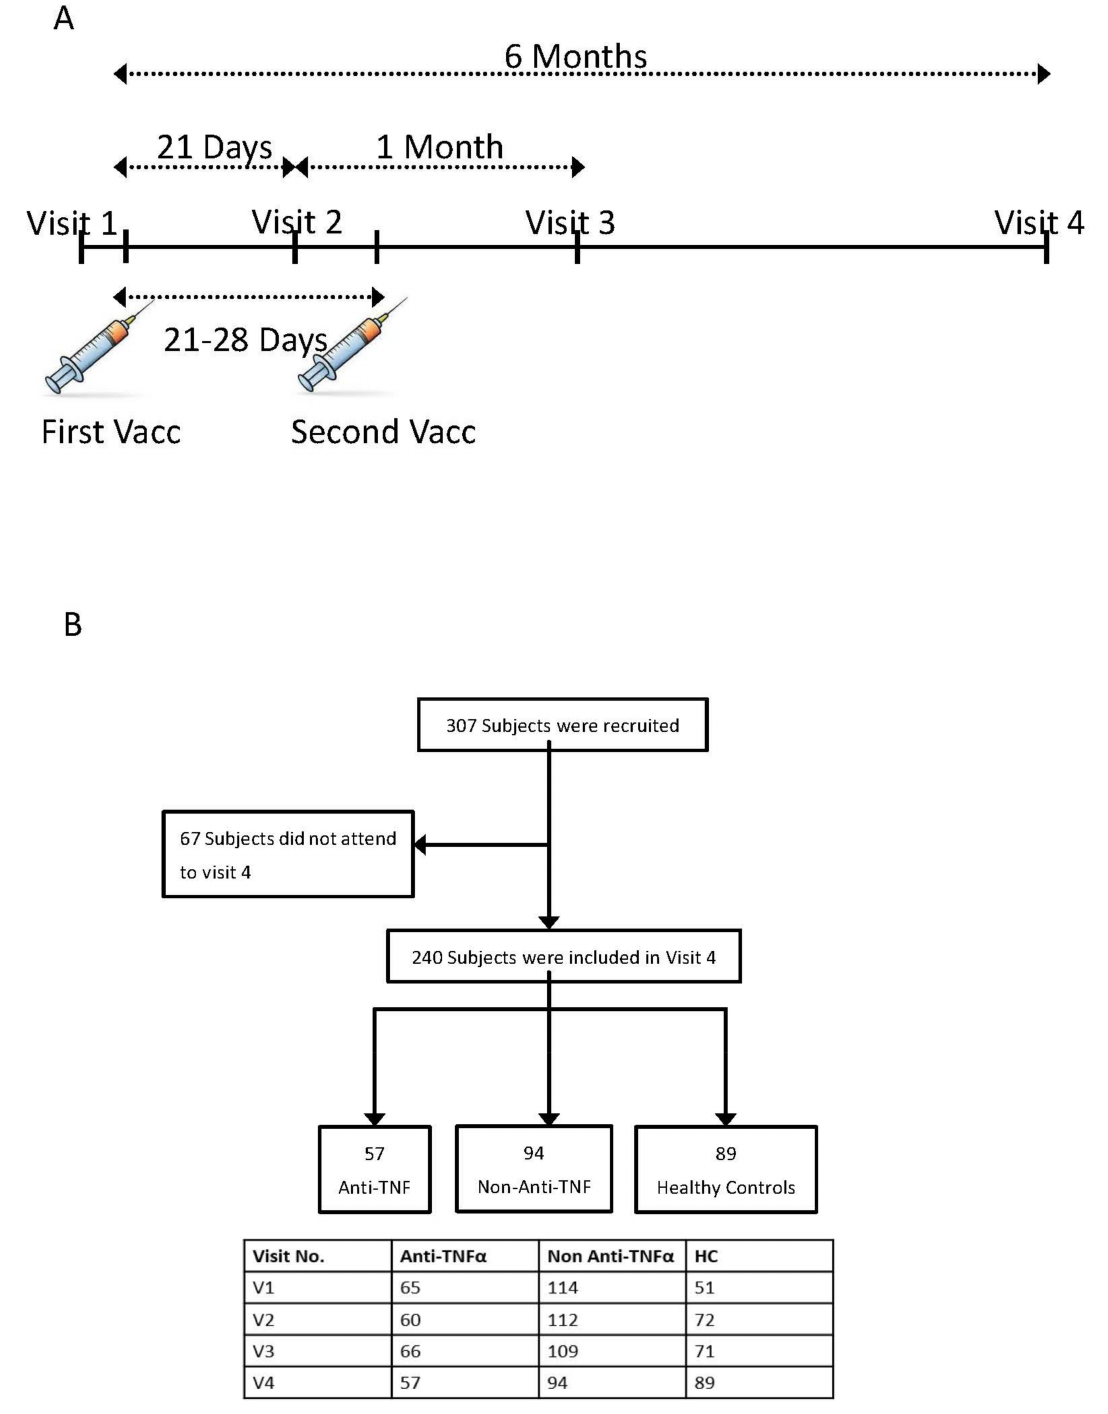
Figure 1. ( A ) Study protocol. Patients were enrolled at visit 1, before the first vaccine dose. Visit 2 was 14–21 days after the first but before the second vaccine dose. Visit 3 and 4 were one and 6 months after the first vaccine dose, respectively. In each visit, laboratory tests were performed and questionnaires regarding disease severity and adverse events (AEs) were filled. ( B ) Patient disposition. The diagram represents all enrolled participants who were recruited before vaccination. In total, 25 subjects were recruited at the second visit (after first vaccine dose but before the second one), mainly due to logistic reasons. Most of them (19) were healthy controls (HCs). Number of subjects at each visit is detailed in the table below the diagram. Abbreviations: HC—healthy control; Vacc—vaccine